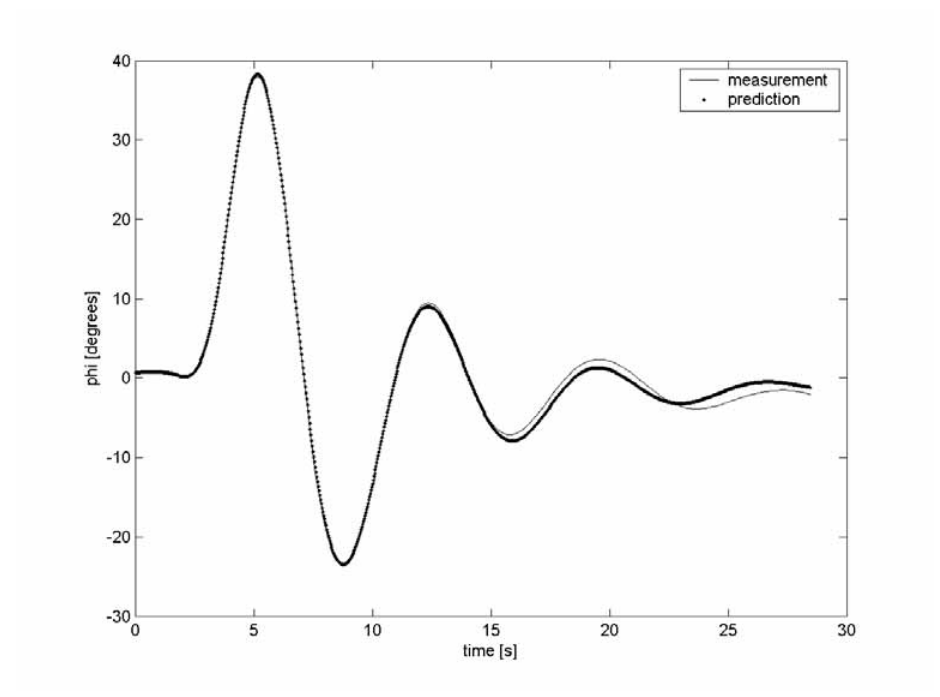
Fig. 11. Measured bank angle and estimated